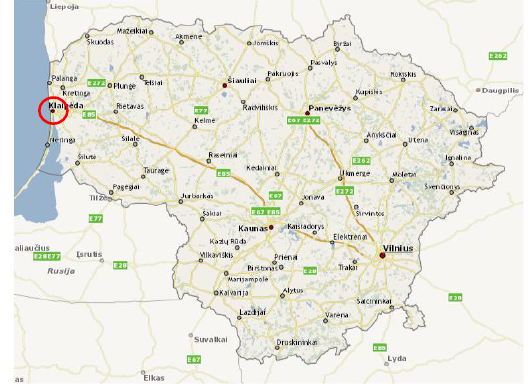
Figure 1. Location of study area (source: www.maps.lt)